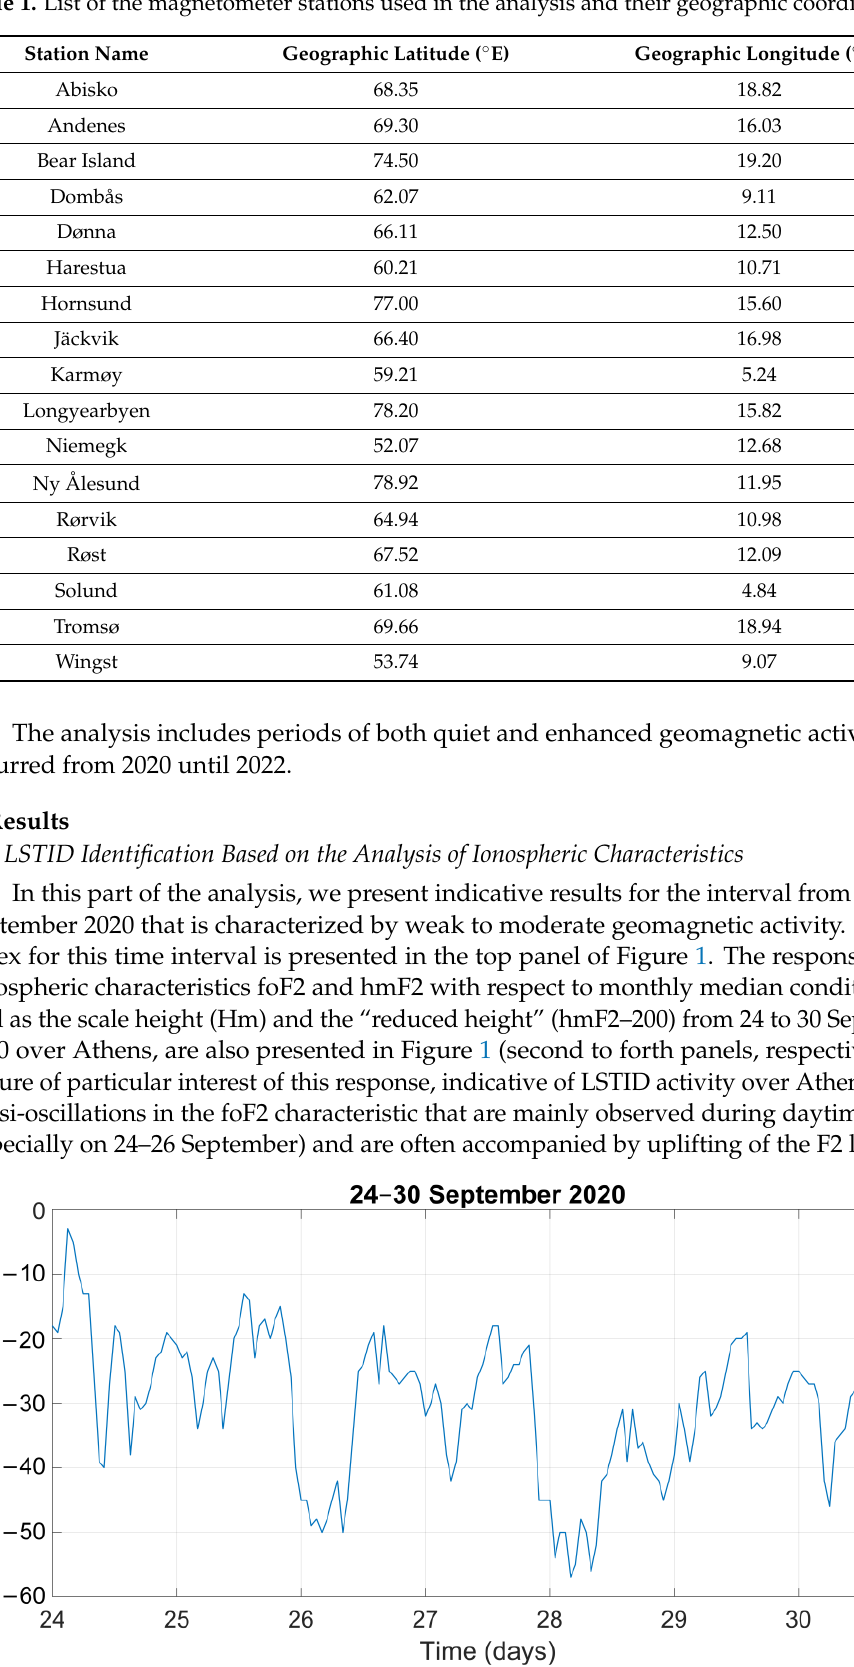
Table 1. List of the magnetometer stations used in the analysis and their geographic coordinates.